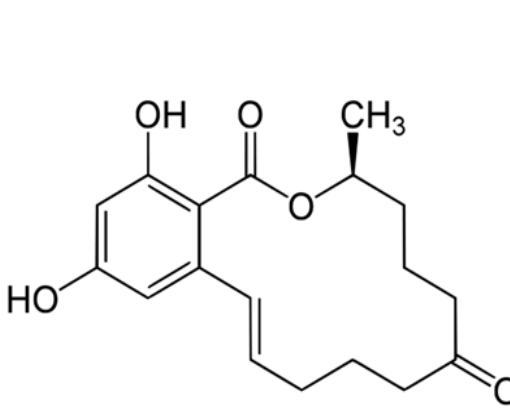
Fig. 1. The molecular structure of Fig.1